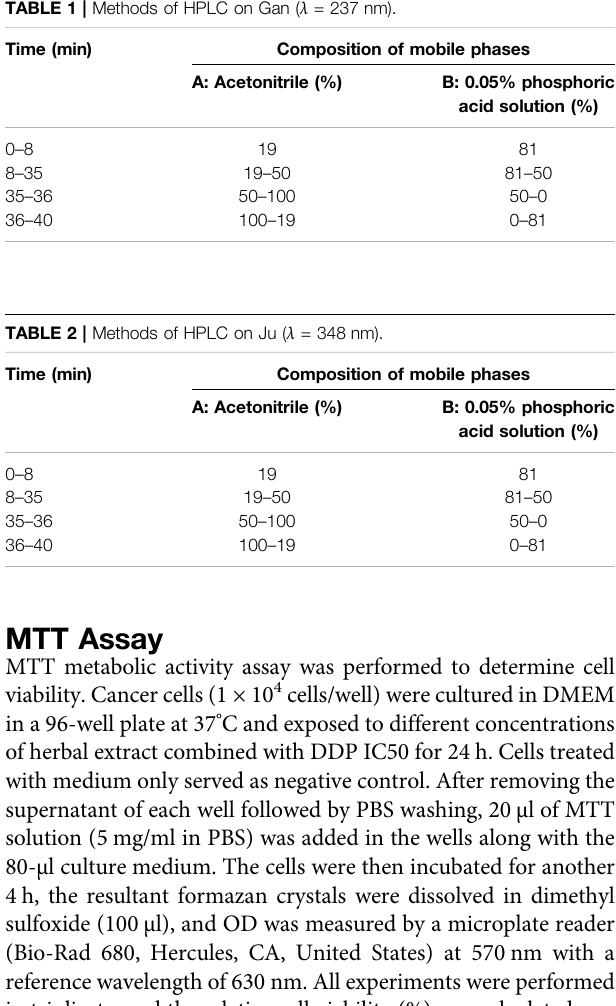
TABLE 1 | Methods of HPLC on Gan ( λ = 237 nm).